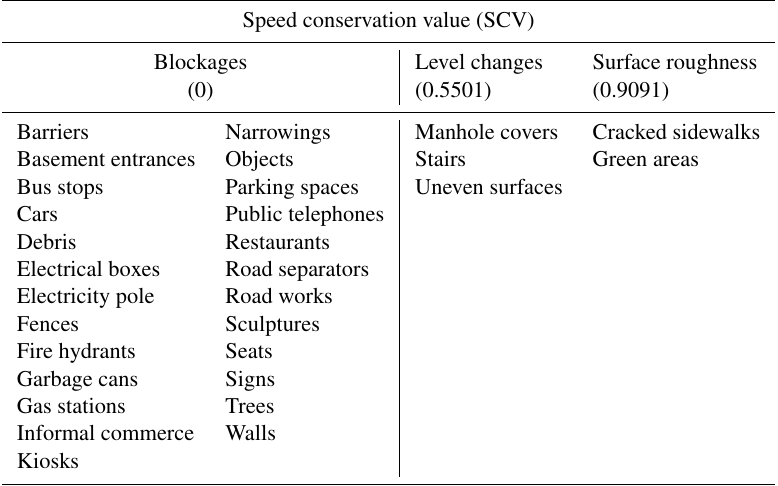
Table 2. Speed conservation of micro-vulnerabilities present on evacuation routes.